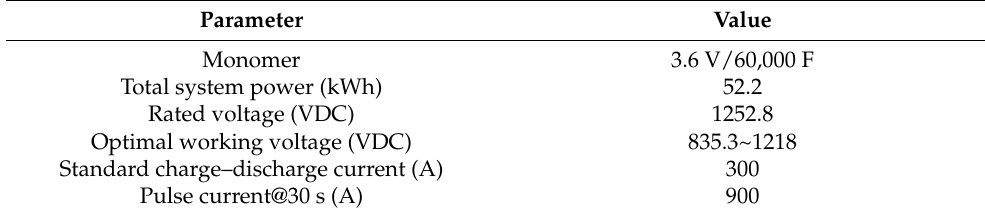
Table 8. The system parameters of the ground energy storage